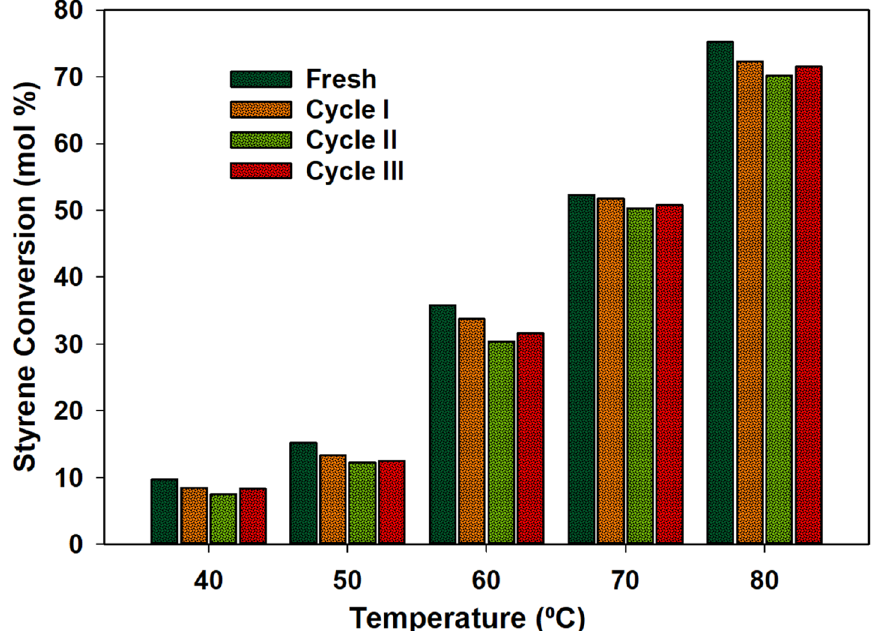
Figure 9. Conversion of styrene over the temperature over the Ru-Pth catalyst under conditions: catalyst: styrene (1:100); styrene: